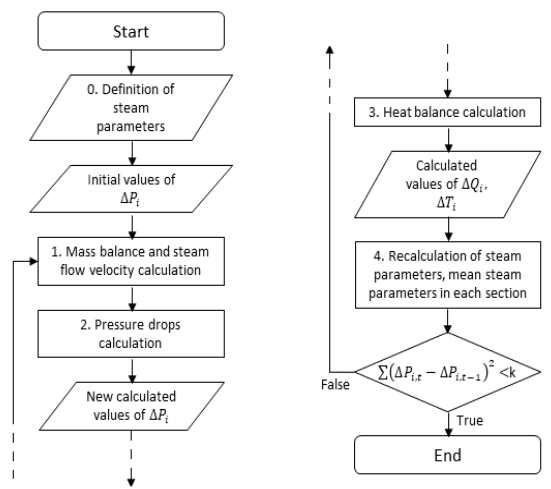
Figure 2. Calculation algorithm of the thermo-hydrodynamic model.